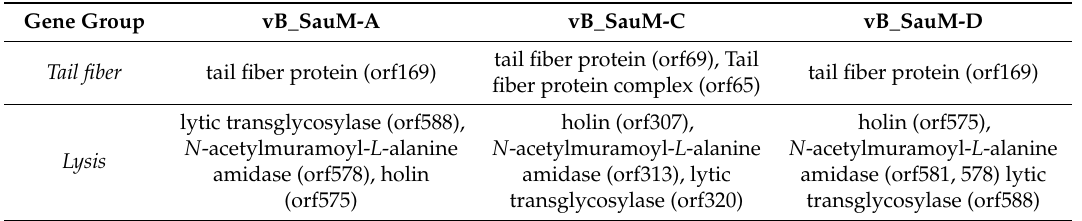
Figure 5. Phylogeny of newly isolated bacteriophages described in this work.